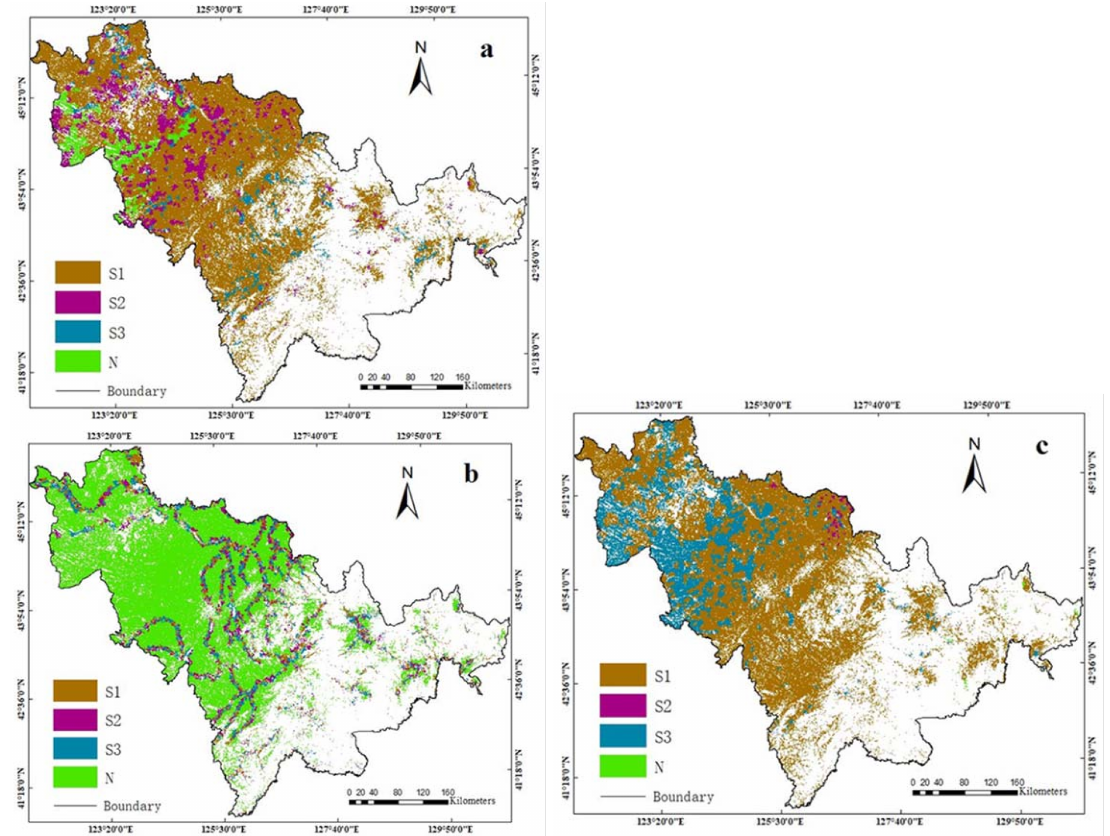
Figure 5. Suitability evaluation map of different agricultural land areas in Jilin Province. ( a ) Land suitability assessment map for maize; ( b ) land suitability assessment map for rice; ( c ) land suitability assessment map for soybeans. S1: highly suitable, S2: moderately suitable, S3: marginally suitable, N: